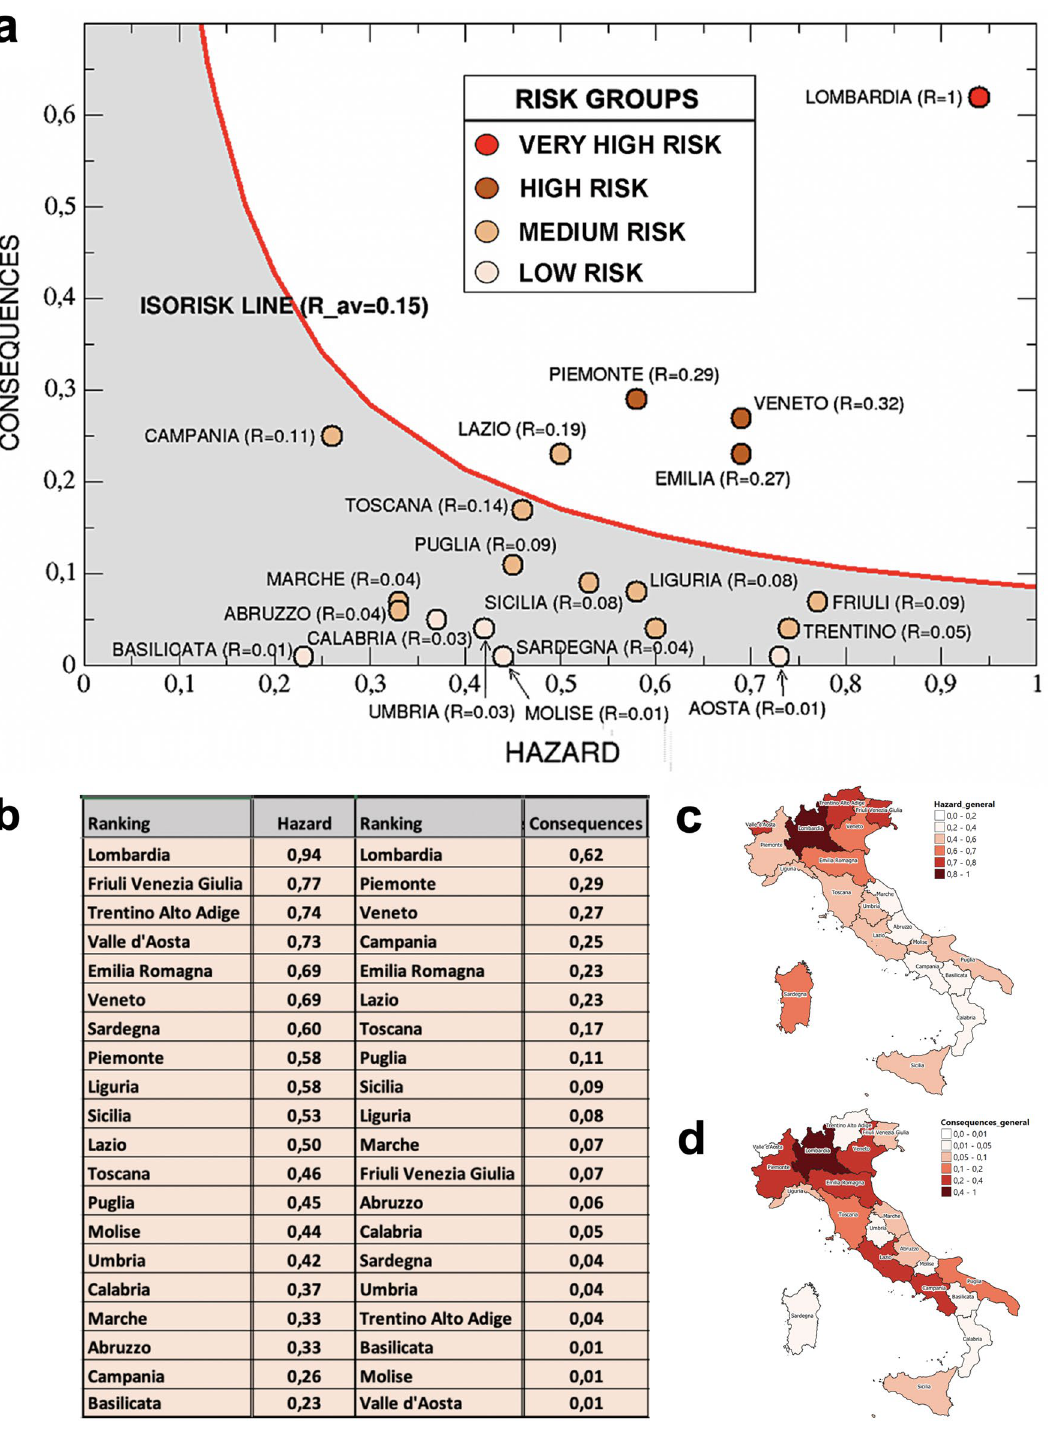
Figure 5. ( a ) Risk Diagram. Each region is represented as a point in the plane { H × C } while the color is proportional to the corresponding risk group updated at July 14, 2020 (see Fig. 3a). The most damaged regions lie with a good approximation above the C = R av /H hyperbole (i.e. the iso-risk line related to the average regional risk index), while the less damaged ones lie below this line. The a-priori risk index score is also reported for each region. ( b ) The rankings of Italian regions according to either Hazard (on the left) or Consequences (on the right). The corresponding colored geographic maps are also shown in panels ( c ) and ( d ) for comparison. Maps were realized with QGIS 3.10 (https:// qgis. org/ en/